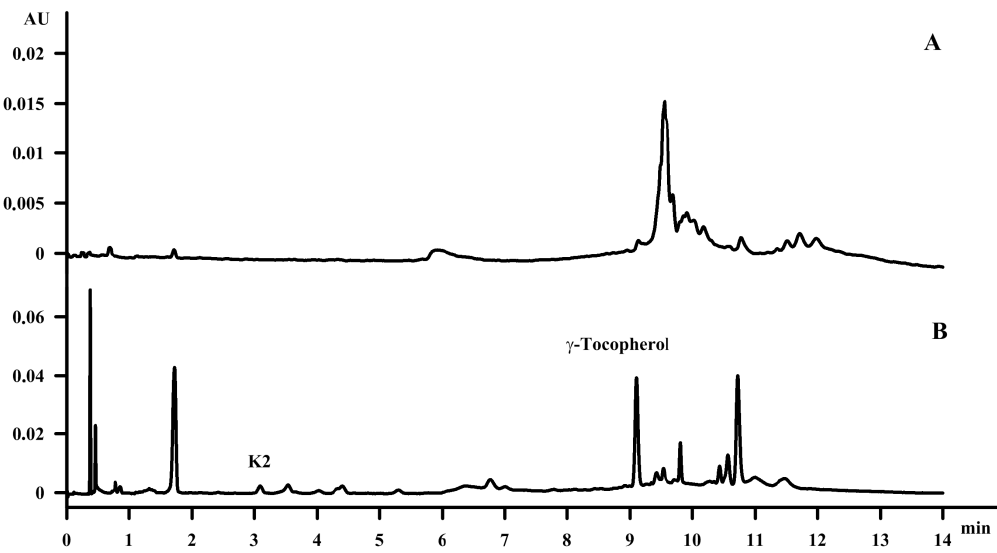
Figure 5. The chromatogram of hemp seed oil—before purification ( A ), after purification ( B ).